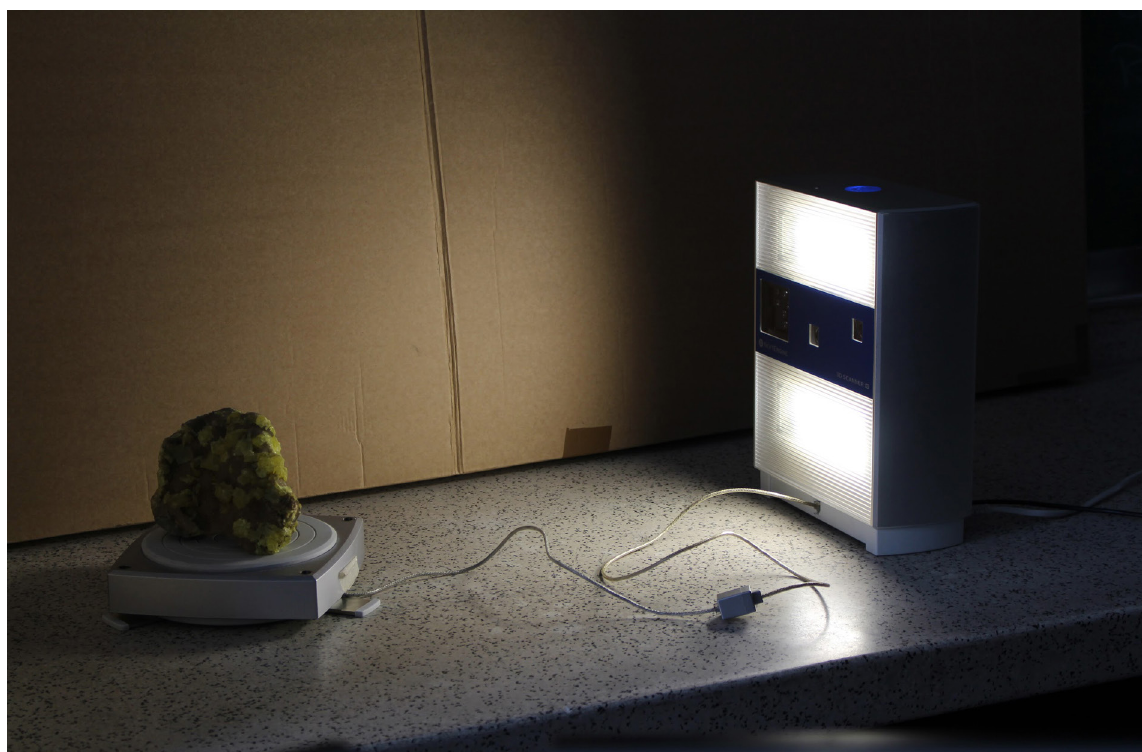
comes with a sample holder to scan small samples.